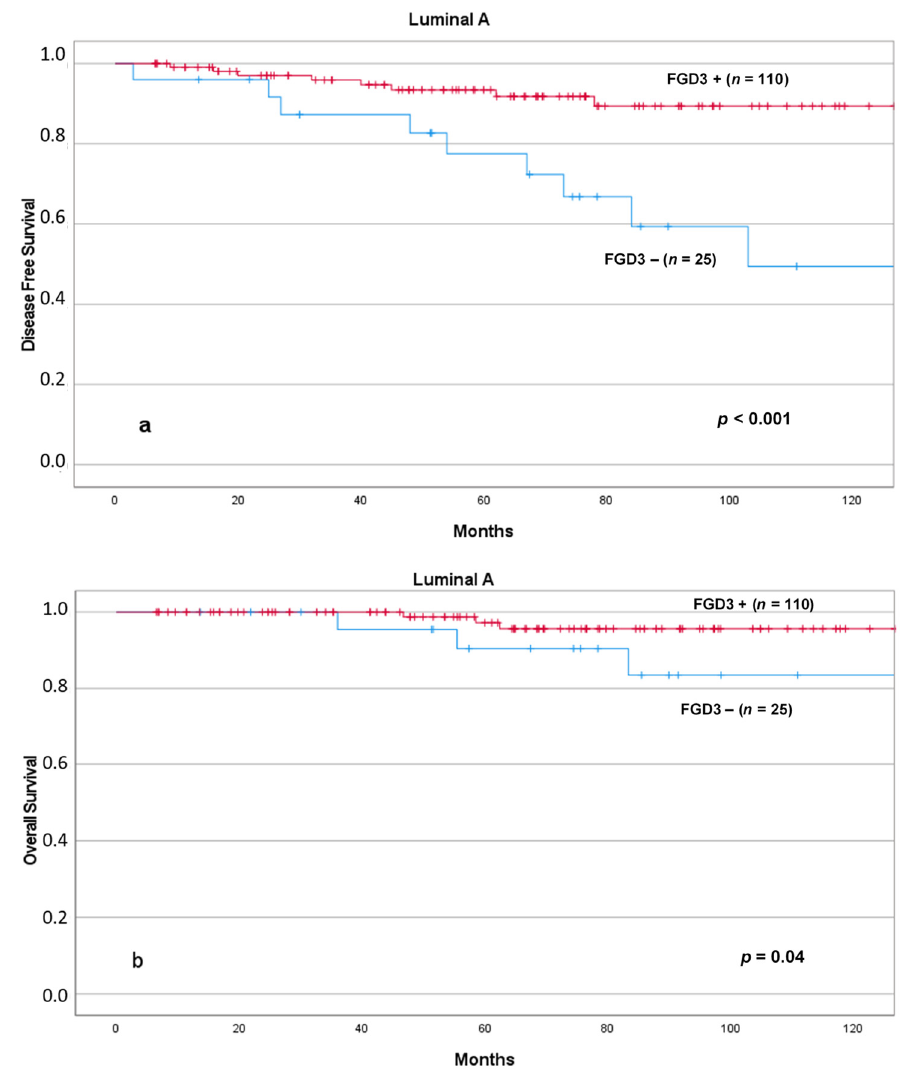
Figure 7. DFS ( a ) and OS ( b ) according to FGD3 expression in patients with Luminal A tumors. Abbreviations: FGD3+: high FGD3 expression; FGD3 − : low FGD3 expression.